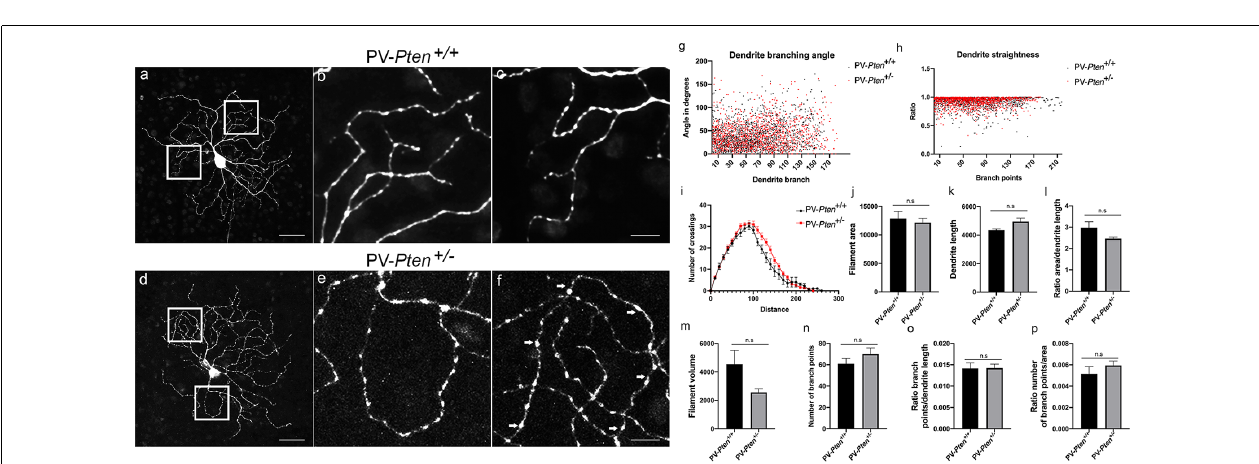
FIGURE 5 | Morphology of OFF α -RGCs in PV- Pten +/+ and PV- Pten + / − retinas. (A) Neurobiotin-filled OFF α -RGC in a PV- Pten +/+ retina showing the dendritic architecture. (B) High magnification (box area from A ) of dendrites showing little overlap. (C) Another high magnification example (box area from A ) of dendrites showing little overlap. (D) Neurobiotin-filled OFF α -RGC in the PV- Pten + / − retina showing dendritic architecture. (E) High magnification (box area from C ) of dendrites showing a loop-forming dendrite. (F) Another high magnification example (box area from A ) of dendrites showing a loop-forming dendrite (arrows). Comparison of dendritic morphology of OFF α -RGCs in PV- Pten +/+ ( n = 9 cells) and PV- Pten + / − ( n = 12 cells) retinas. (G) Dendrite branching angle ( P > 0.05, Mann-Whitney test). (H) Dendrite straightness ( P > 0.05, Mann-Whitney test). (I) Sholl analysis ( P > 0.05 at all radii, Mann-Whitney test). (J) Filament area ( P > 0.05, Mann-Whitney test). (K) Dendrite length ( P > 0.05, Mann-Whitney test). (L) Ratio area to dendrite length ( P > 0.05, Mann-Whitney test). (M) Volume ( P > 0.05, Mann-Whitney test). (N) Branch points ( P > 0.05, Mann-Whitney test). (O) Ratio of branch points to dendrite length ( P > 0.05, Mann-Whitney test). (P) Ratio to branch points to area ( P > 0.05, Mann-Whitney test). z-step = 0.3 µ m. 80–95 optical sections were compressed for viewing. Scale bars: 50 µ m (A,D) , 10 µ m (B,C,E,F) . n.s., not